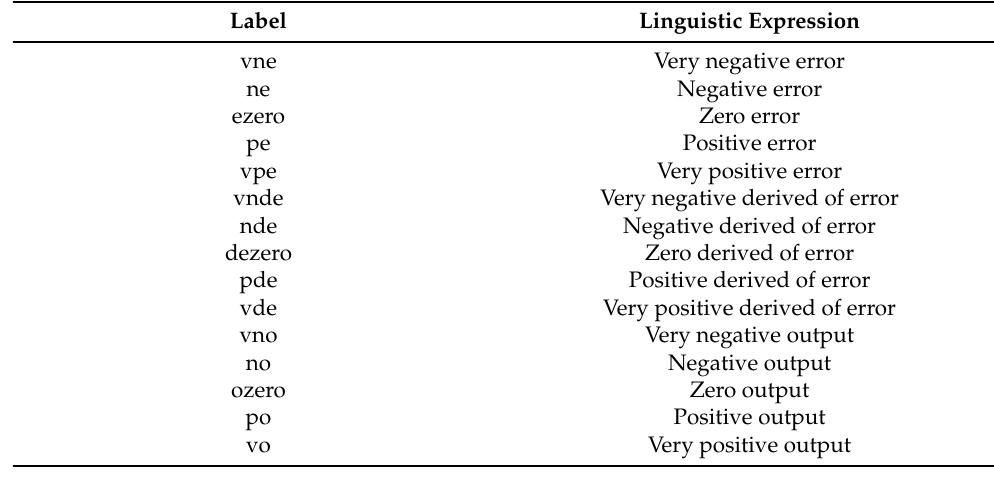
Table 1. Linguistic expressions for the output, error and the derived of error.